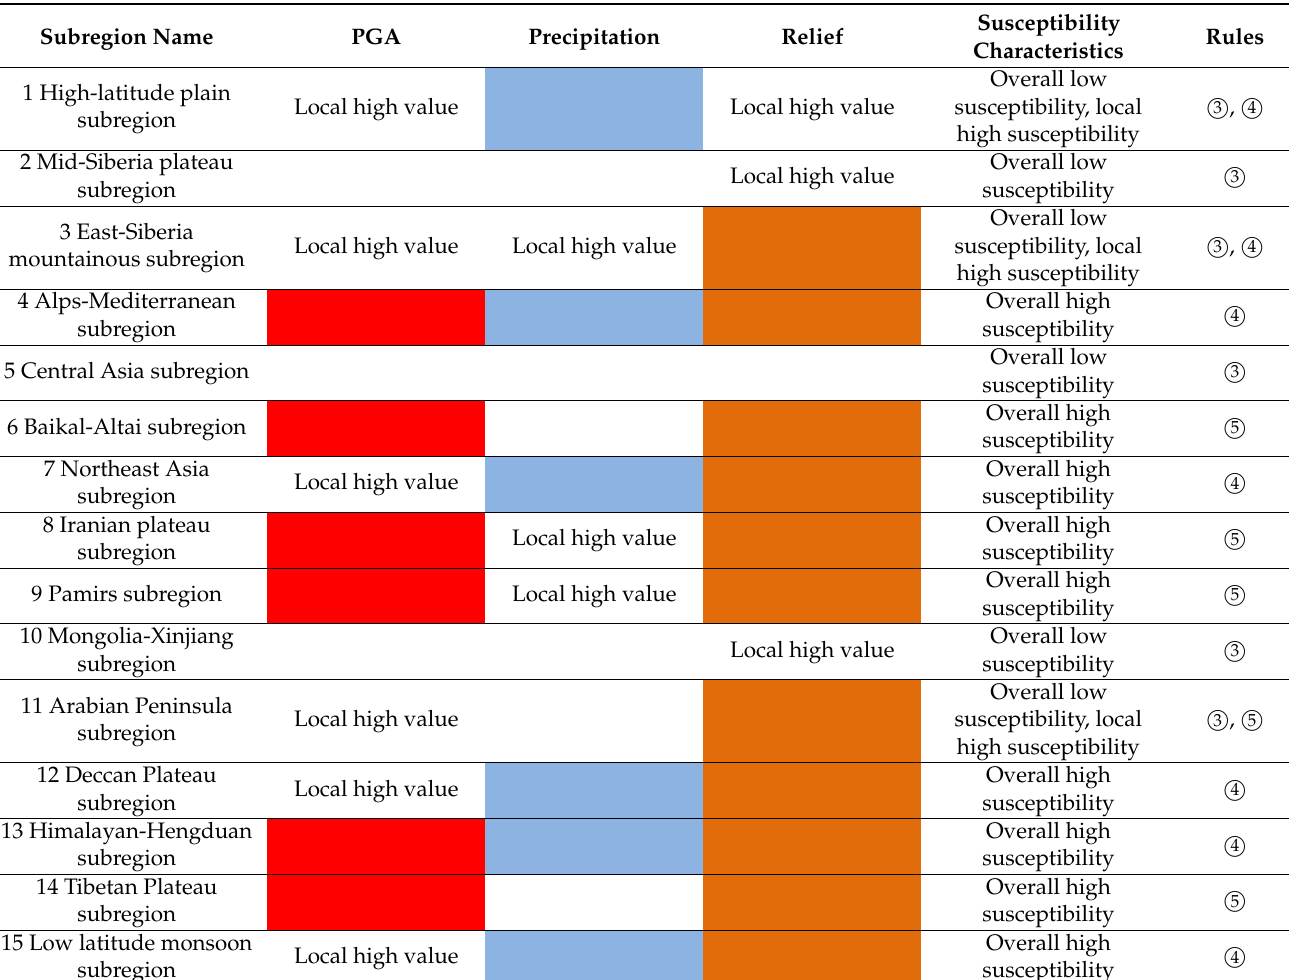
Table 1. Relative strength table of PPR in each subregion and inference of mountain-hazards